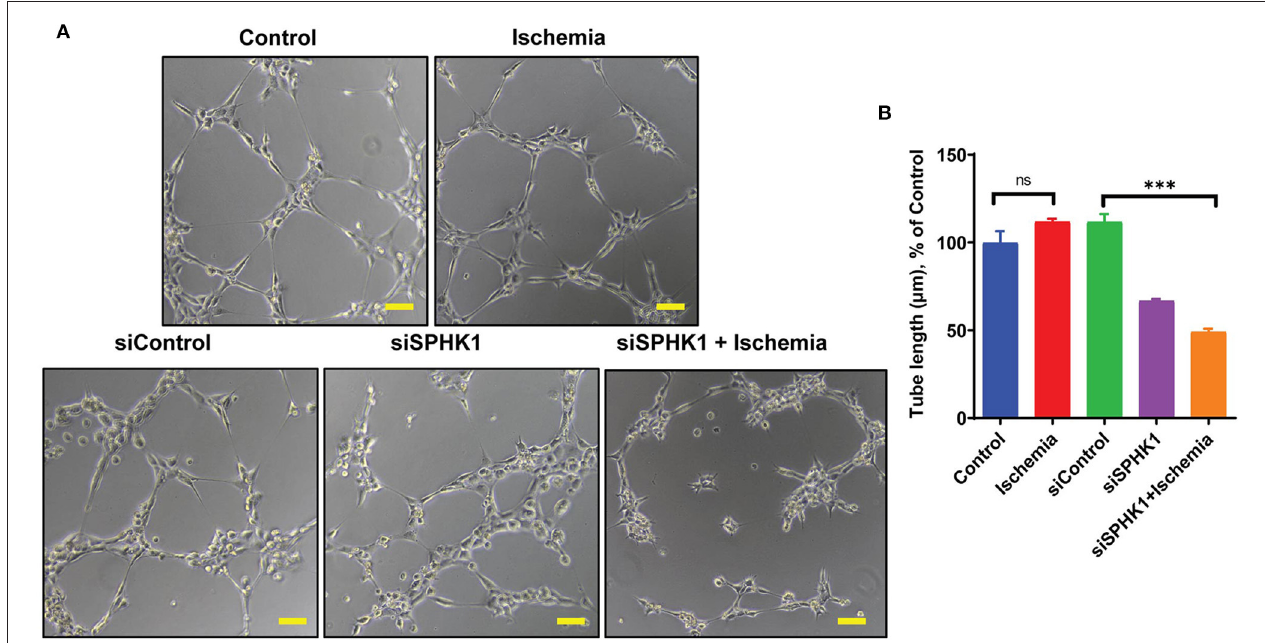
FIGURE 7 | SPHK1 regulates endothelial cell tube formation under ischemic stress. (A) SPHK1 was downregulated using 30nM siSPHK1 siRNA. For tube formation analysis, cells were trypsinized and seeded on matrigel. (B) ECs tubes length was observed under the microscope at 100X magnification and tube length was measured with ImageJ (NIH) software (around 50–70 branch points were measured to take the average for each specimen). The scale bar on Image represents 50 µ M pixel size. The data are shown as means ± SEM using one-way ANOVA followed by Tukey’s multiple comparison test. *** P < 0.001, ns indicates not significant with respective control ( n =